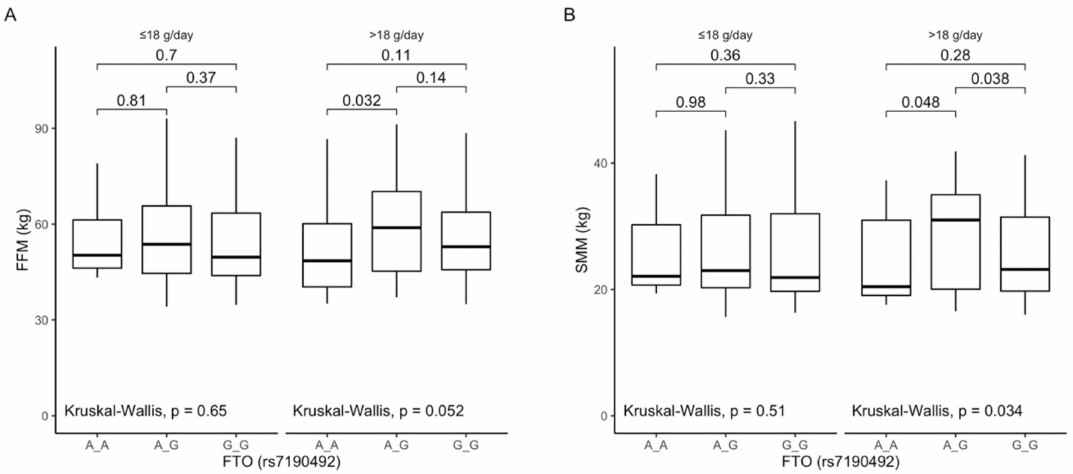
Figure 5. Association of the FTO rs7190492 genotypes with ( A ) Fat-free mass content (FFM) (kg); ( B ) Skeletal muscle mass content (SMM) (kg) by dietary fiber intake strata: ≤ 18 g/day and >18